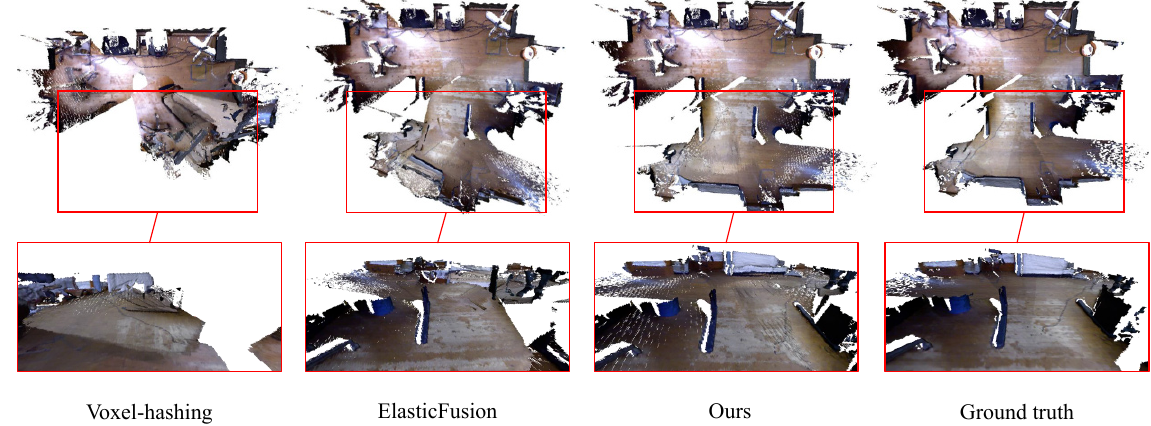
Fig. 5 Reconstruction results for different methods on fr1/floor from the RGB-D benchmark [22] with frame difference